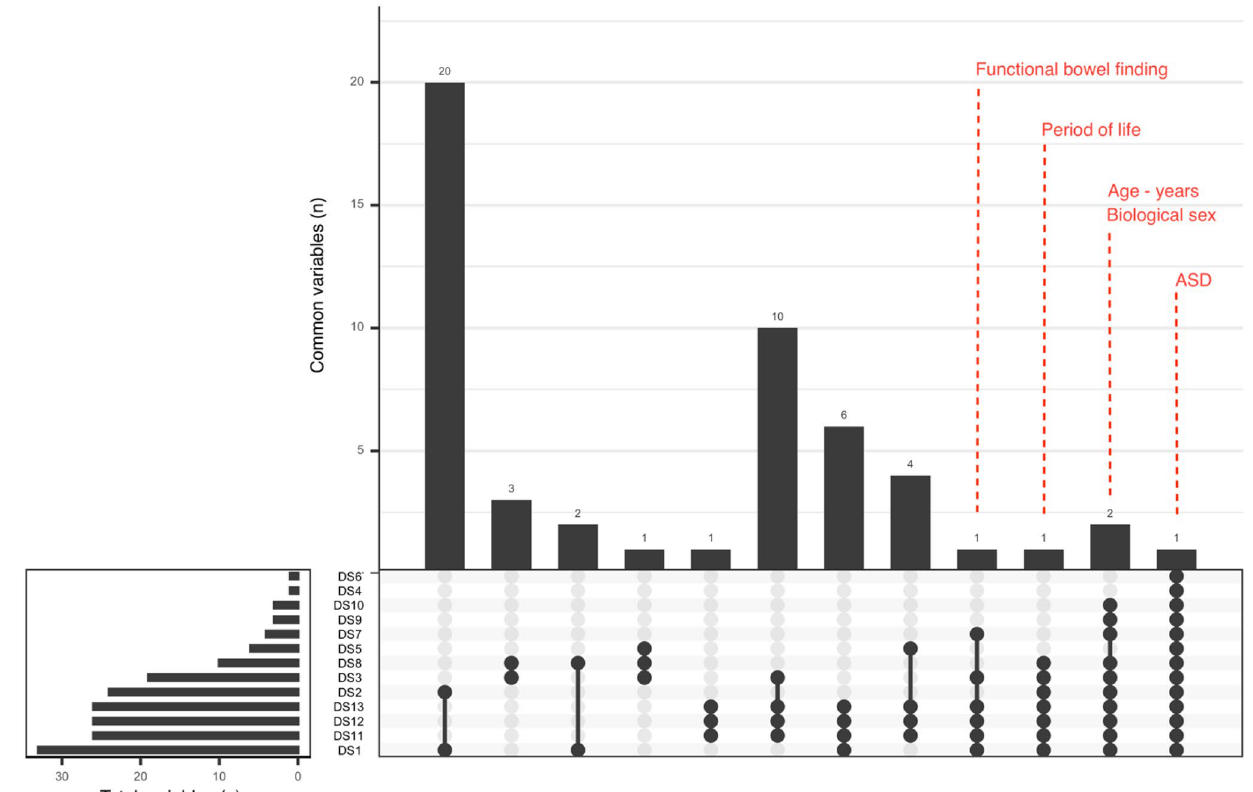
Figure 1. Concordance of metadata variables across datasets. Each bar represents the number of common variables between datasets and solid black circles below the bar indicate datasets that contain the intersected set of variables. The “Total variables” inset displays the total number of metadata variables for each dataset. The top (present in at least 6 datasets) intersected variables are labelled while the remaining variables are listed in Supplementary file 1: Table